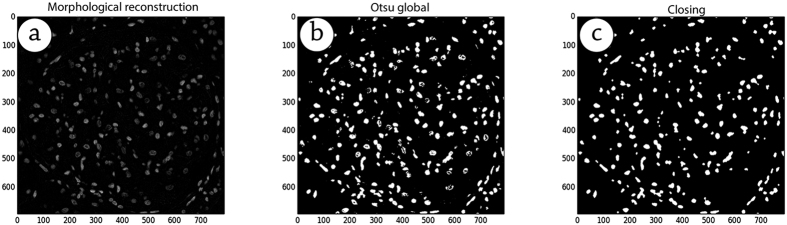
Segmentation stages.